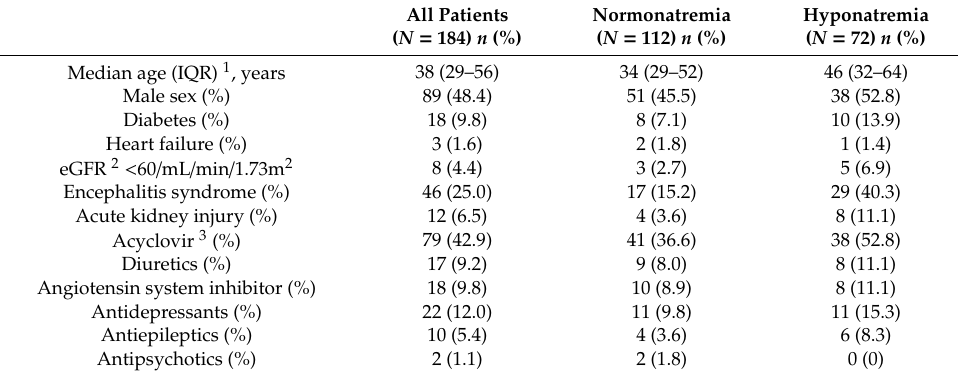
Table 1. Patient characteristics and medication use by hyponatremia